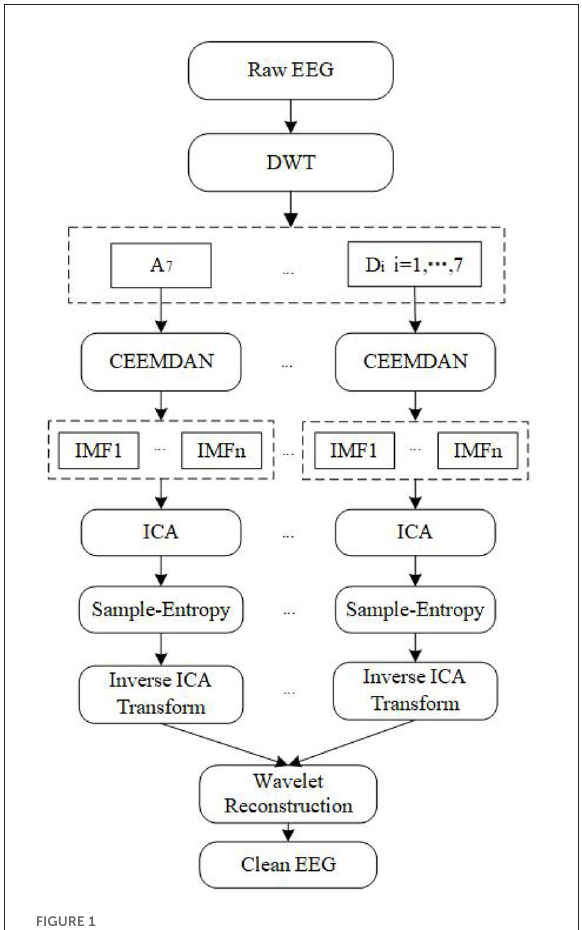
FIGURE1 Flowchart of